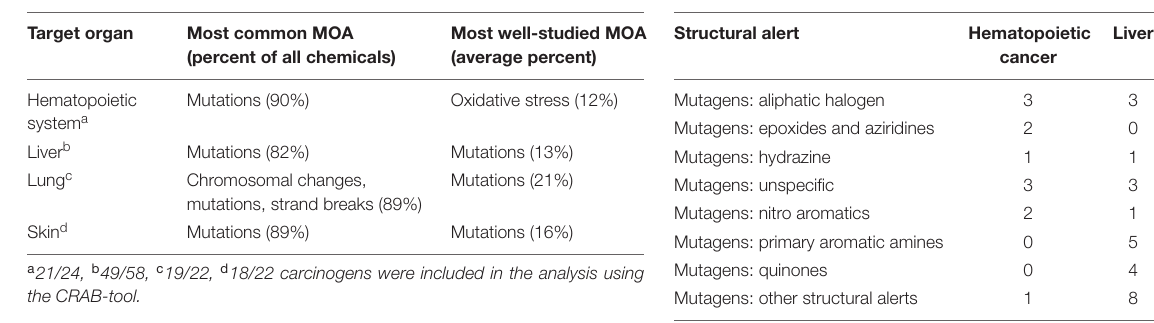
TABLE 3 | The number of carcinogens with predicted structural alerts shown for each target organ.